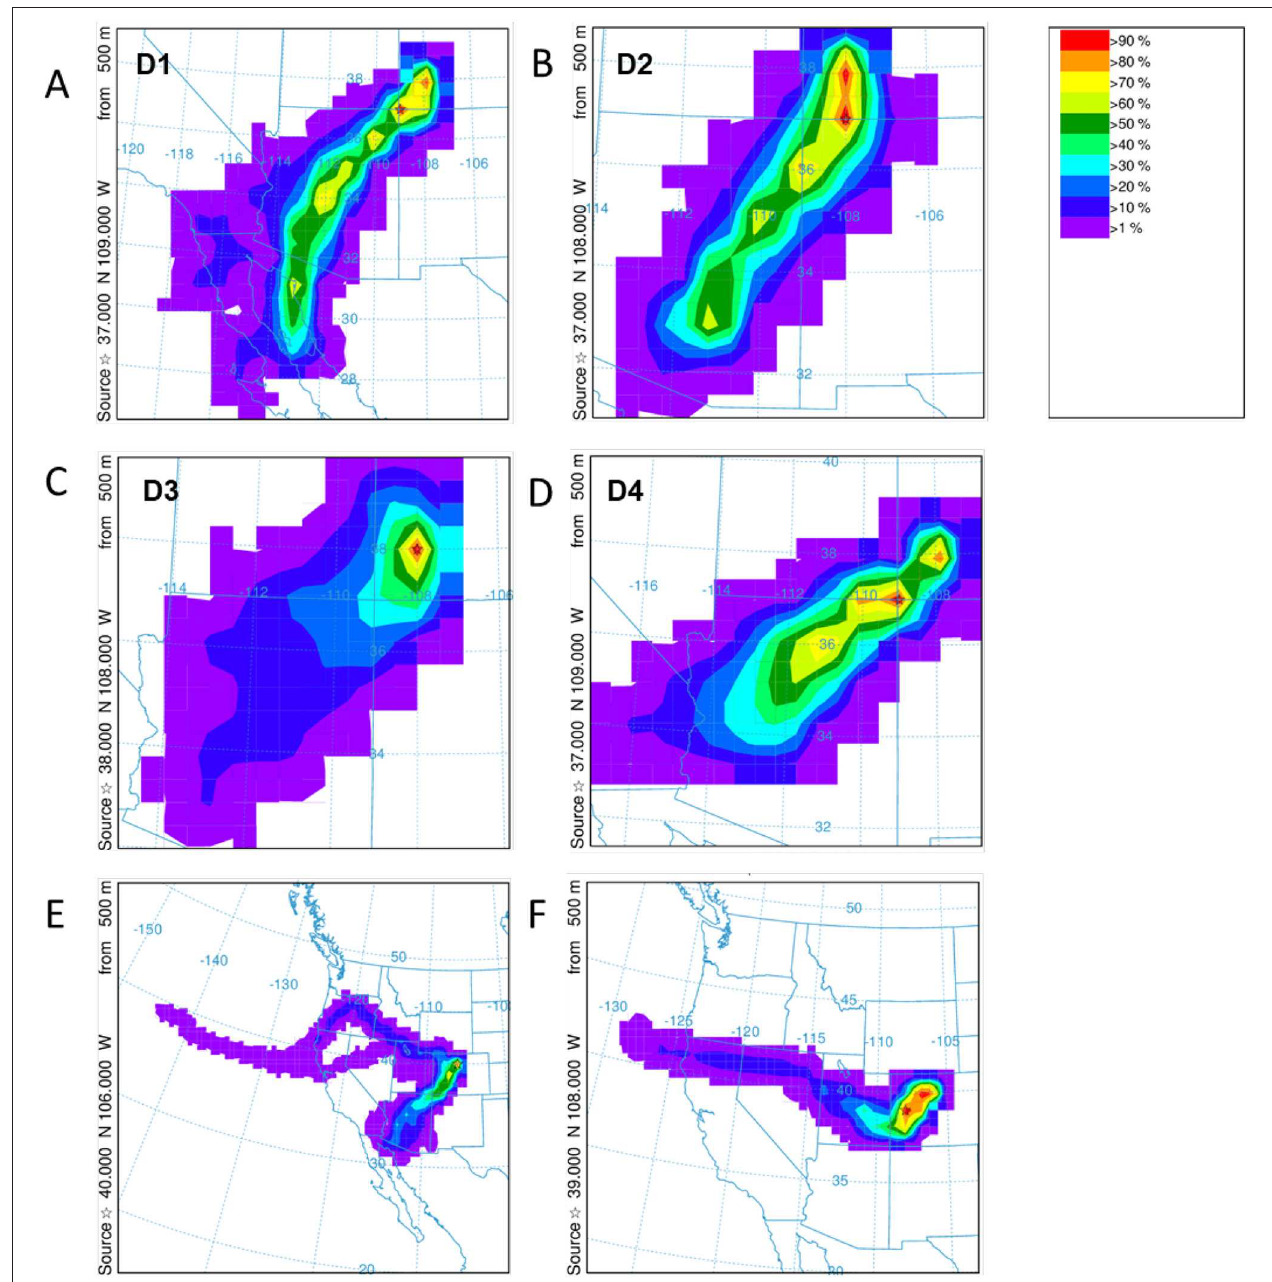
FIGURE 9 | HYSPLIT frequency backward trajectories for the dust deposition events D1–D4 for Swamp Angel Study Plot are shown in (A–D) and Berthoud Pass (E,F) . The storm systems for the identified Berthoud Pass dust events are more diffuse. Note the differences in area between panels.